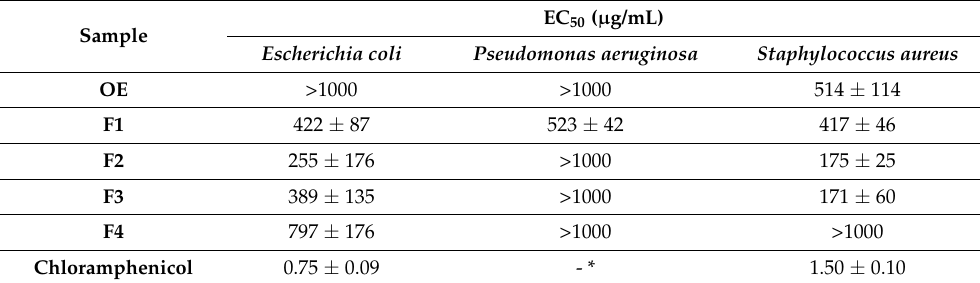
Table 8. EC 50 values of bacterial growth inhibition of OE and F1 – F4 obtained from E. cavolini .